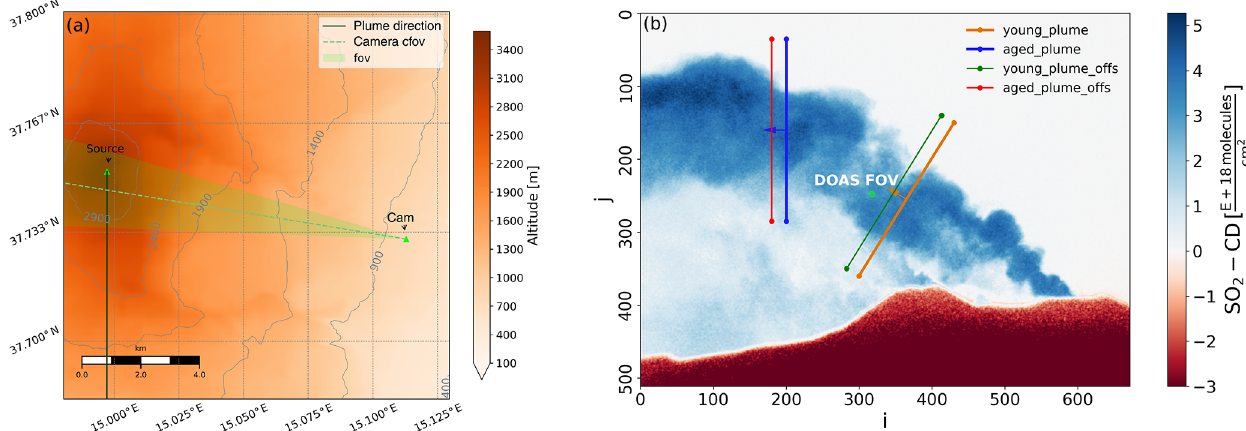
Figure 1. (a) Etna overview map showing position and viewing direction of the camera (camera cfov, fov) which was located on a rooftop in the town of Milo. Also indicated is the summit area (source) and the plume azimuth (plume direction). (b) Example SO 2 -CD image of the Etna plume including two PCS lines (orange, blue) used for emission-rate retrievals and two corresponding offset lines (green, red) that are used for cross-correlation-based plume velocity retrievals (cf. Appendix B4). Position and extent of the DOAS-FOV for the camera calibration are indicated by a green spot. Note that the displayed plume image is size reduced by a factor of 2 (Gauss pyramid level 1). Table 1. Instrumental set-up during both campaigns.